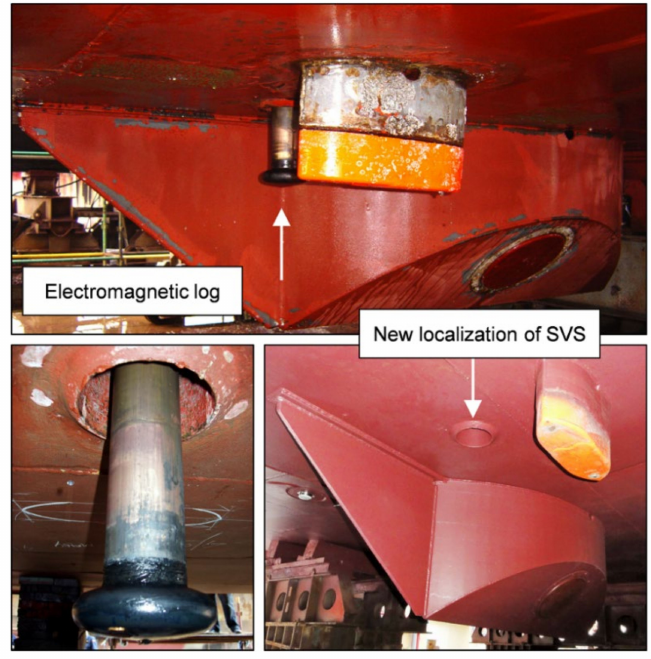
Figure 15. Electromagnetic log head in a lowered position and a new sound velocity sensor location.